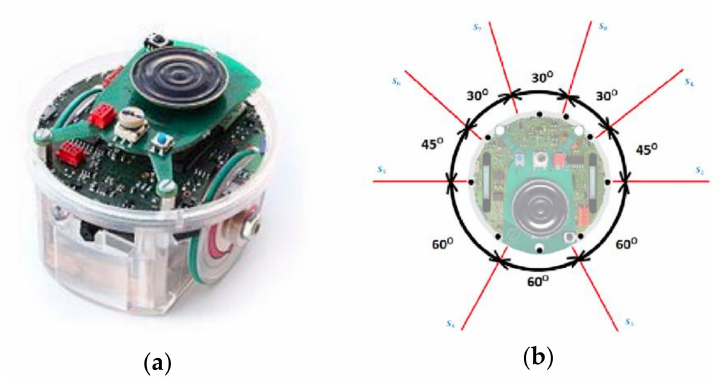
Figure 7. ( a ) E-puck mobile robot; ( b ) E-puck 360 ◦ infrared